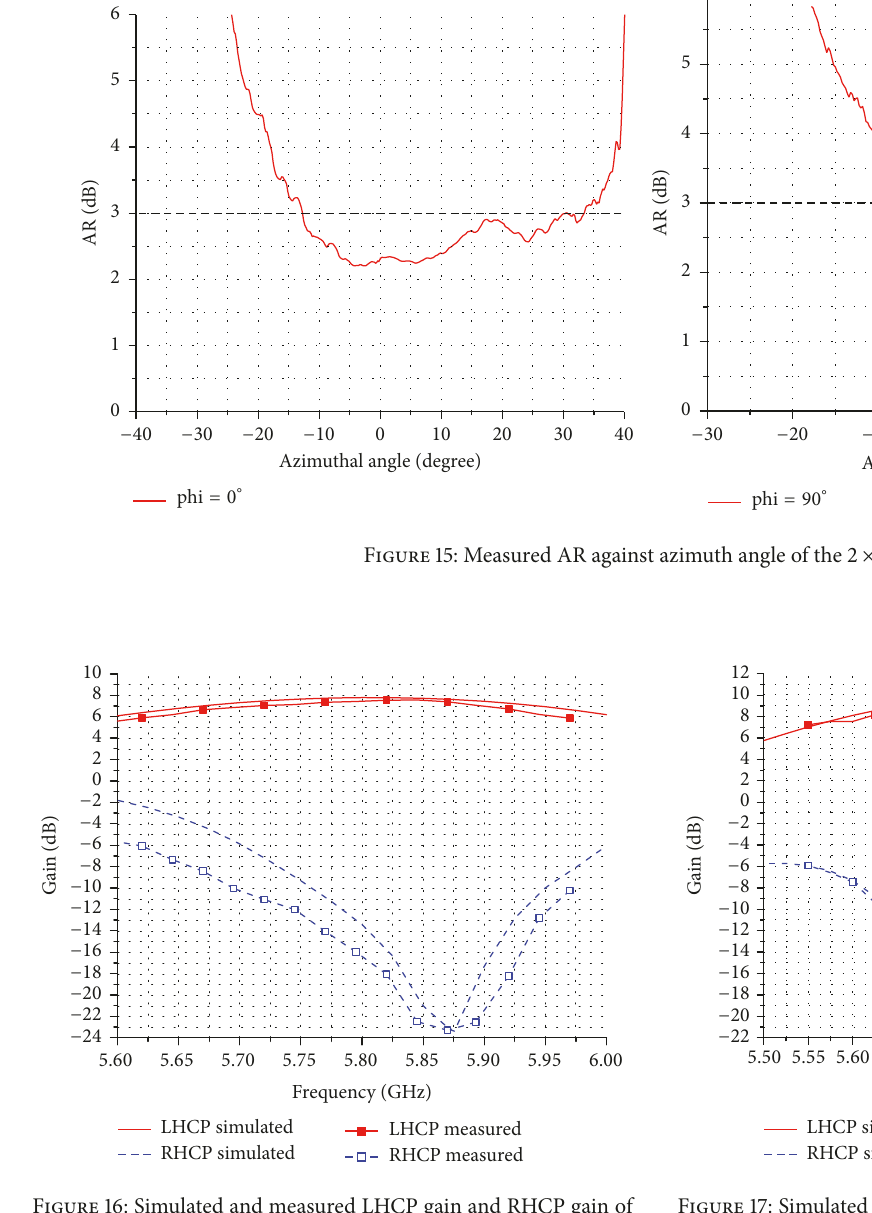
Figure 17: Simulated and measured LHCP gain and RHCP gain of the 2 × 2